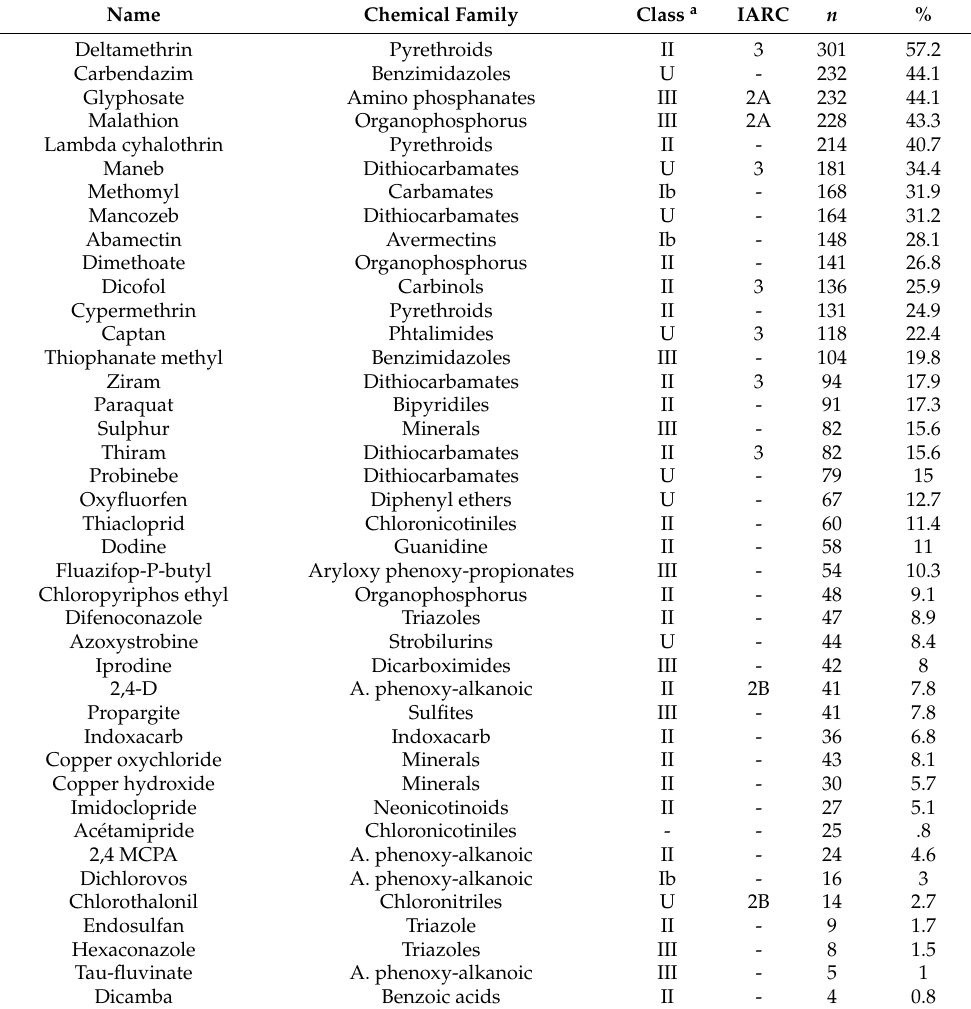
Table 3. Pesticides used by farmers with IARC classification and WHO toxicological